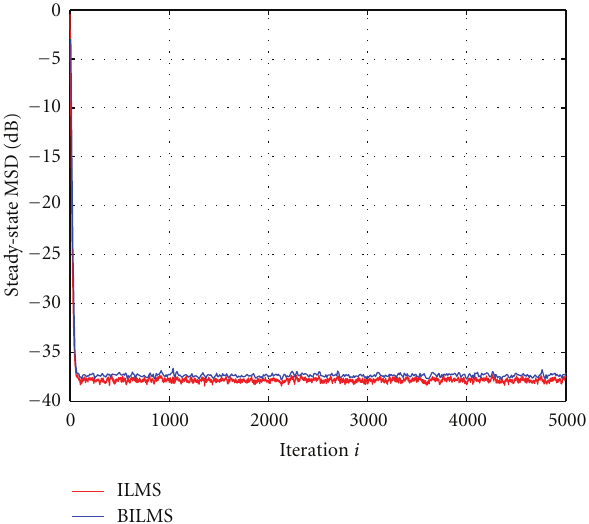
Figure 12: Global mean-square deviation (MSE) curve for incre- mental LMS and block incremental LMS.